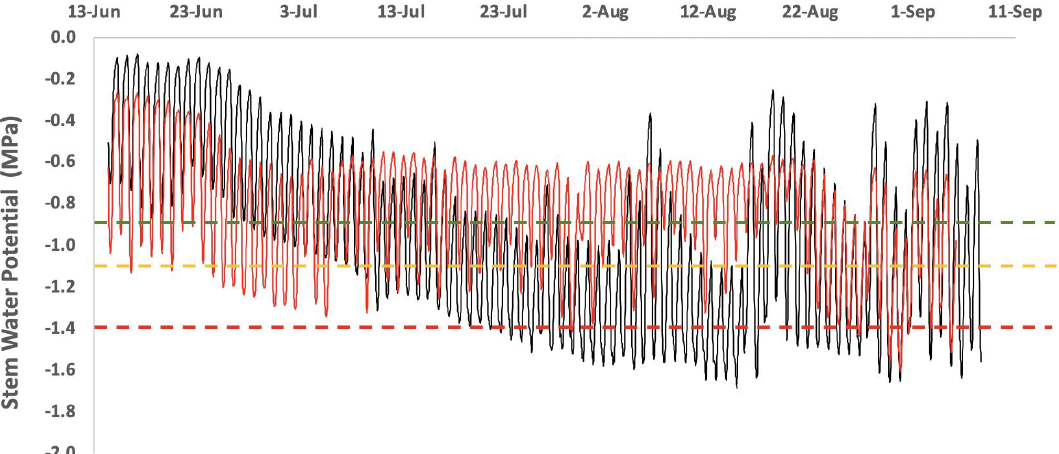
Figure 6. Daily stem water potentials in grapevines over three months with two irrigation regimes in a Mediterranean climate. One (red lines) withheld water relatively early in the season, but then maintained the vines with a mild-moderate stress level. The other regime (black lines) maintained higher water status for a longer period, then irrigation was reduced to allow the vines to become more stressed. The green, orange and red dashed lines at − 0.9, − 1.1 and − 1.4 MPa indicate mid-day stress levels considered mild, moderate and severe, respectively [40]. Data courtesy of E&J Gallo Winery, Modesto, CA, USA.